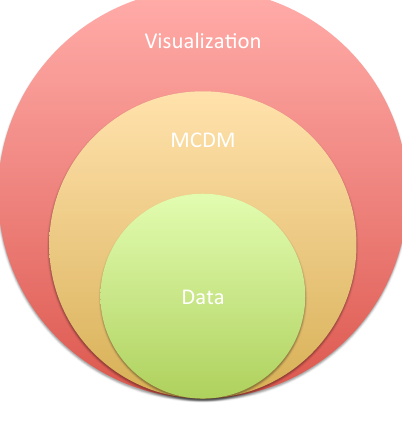
Figure 19. The model of software